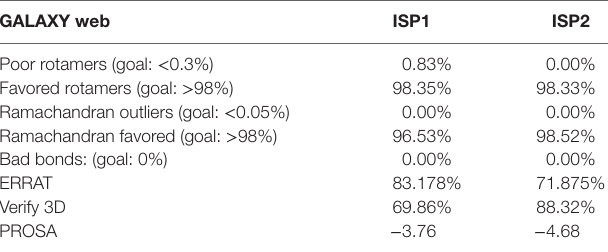
TaBle 1 | Statistical data of ISP1 and ISP2 protein model. galaXY web Poor rotamers (goal: <